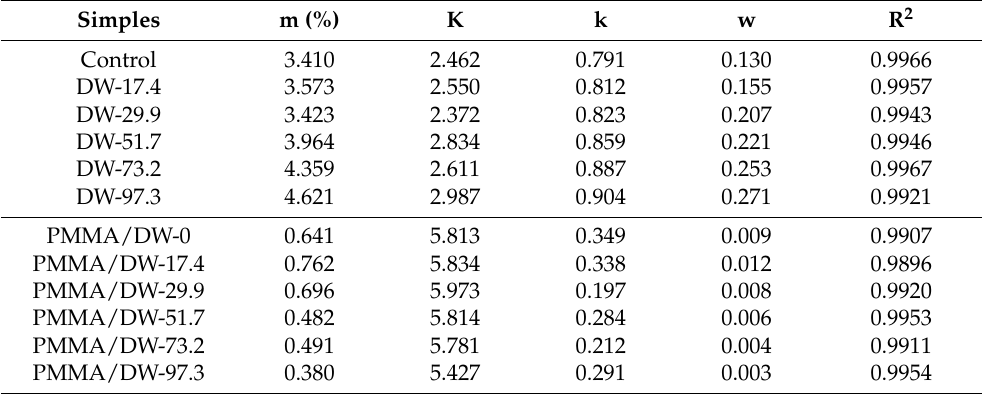
Table 4. The values of the best fit parameters obtained from the fitting of experimental data by the GDW